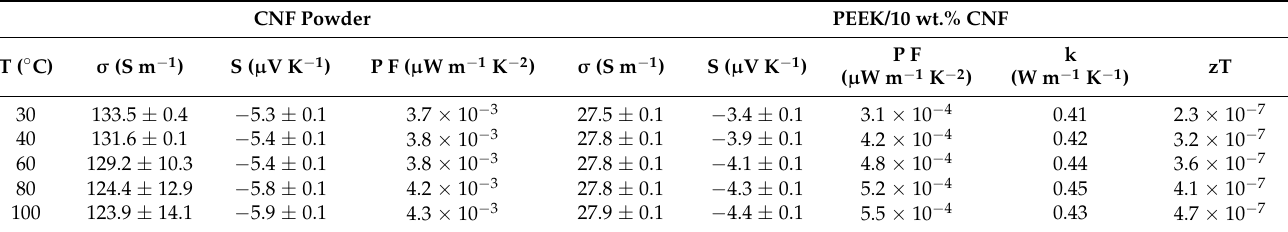
Table 3. Thermoelectric properties of CNF powder and PEEK/10 wt.% CNF composite.